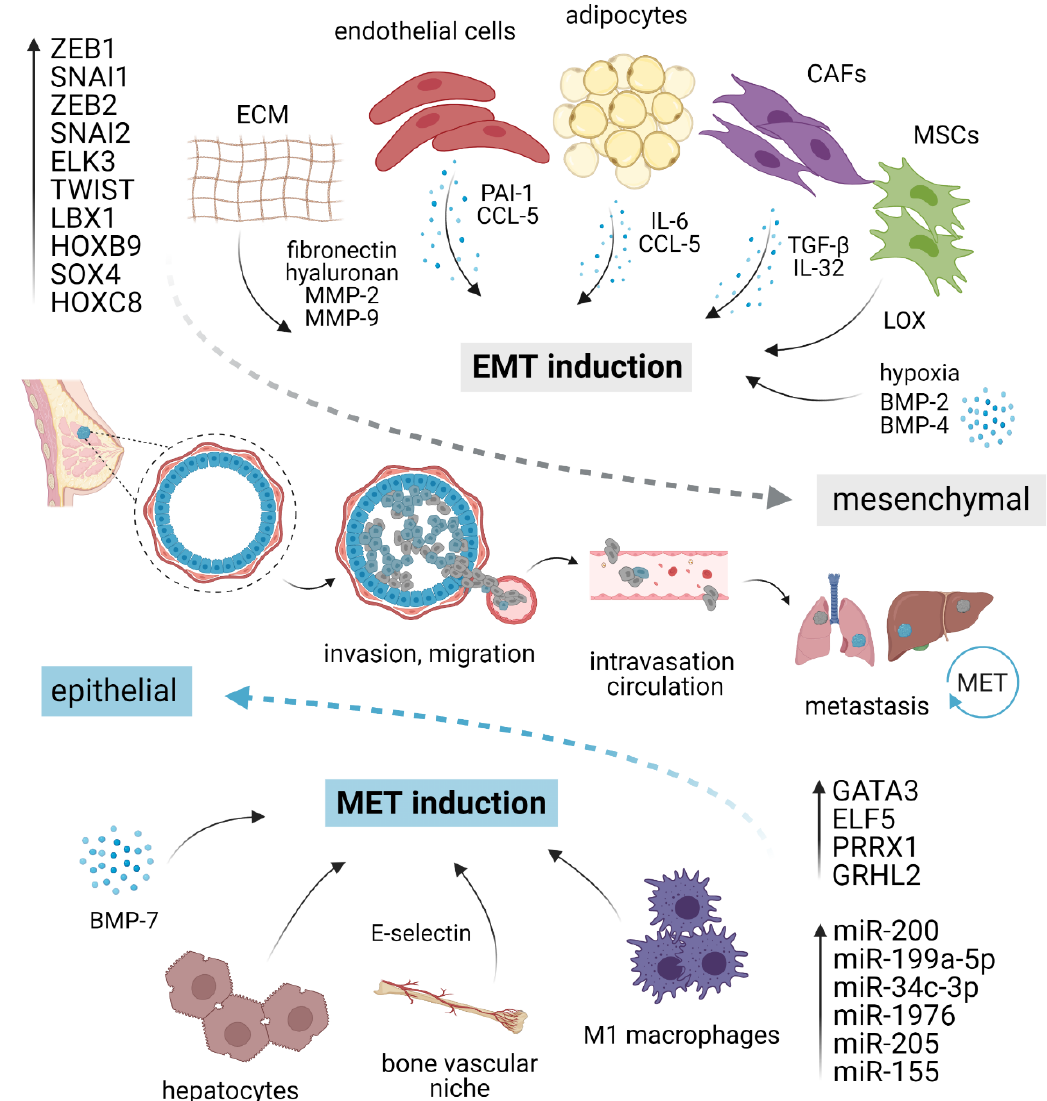
Figure 1. EMT/MET plasticity in breast cancer. EMT is induced by pro-inflammatory cytokines and molecules secreted by different stromal cells present in the tumor microenvironment, ECM elements, and hypoxia. Different cell types such as macrophages or hepatocytes might activate MET. Each program is executed via a specific set of transcription factors and/or corresponding miRNAs. The activation of EMT and mesenchymal phenotype (gray) grants cancer cells the ability to migrate, invade, intravasate, survive in circulation, and extravasate at distant sites. At the secondary organs, mesenchymal cells revert to an epithelial state (blue) through MET, regaining the ability to form macrometastasis. EMT, epithelial–mesenchymal transition; MET, mesenchymal–epithelial transition; CAFs, cancer-associated fibroblasts; MSCs, mesenchymal stromal cells; ECM, extracellular matrix; MMP, matrix metalloproteinase; LOX, lysyl-oxidase. Created with BioRender.